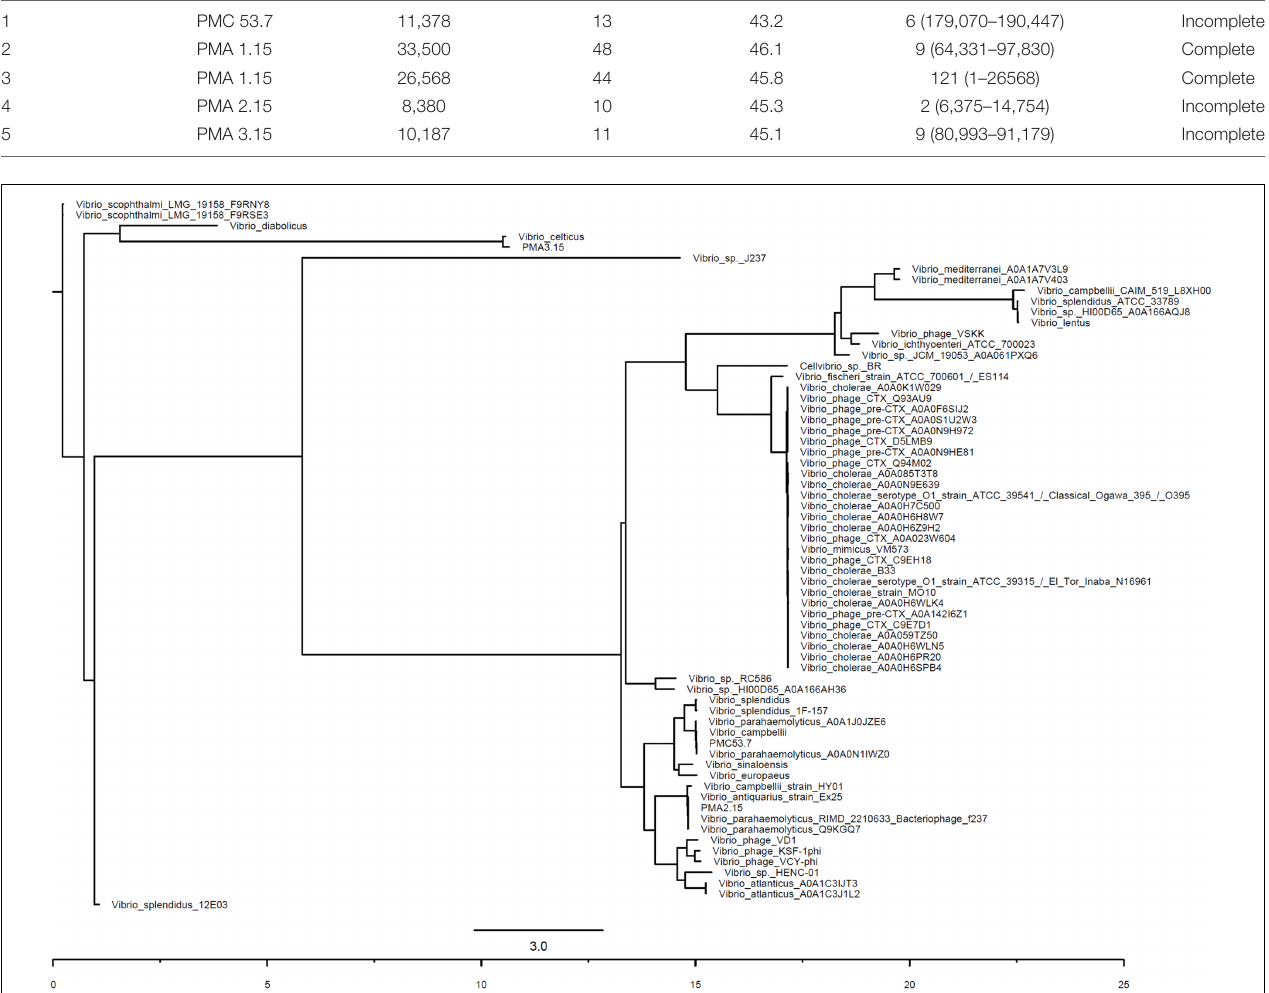
FIGURE 5 | Phylogeny of Zot toxin sequences in Vibrio species. Phylogenetic tree based on Zot protein sequences found in diverse Vibrio species. Maximum-likelihood method, 100 bootstrap values.